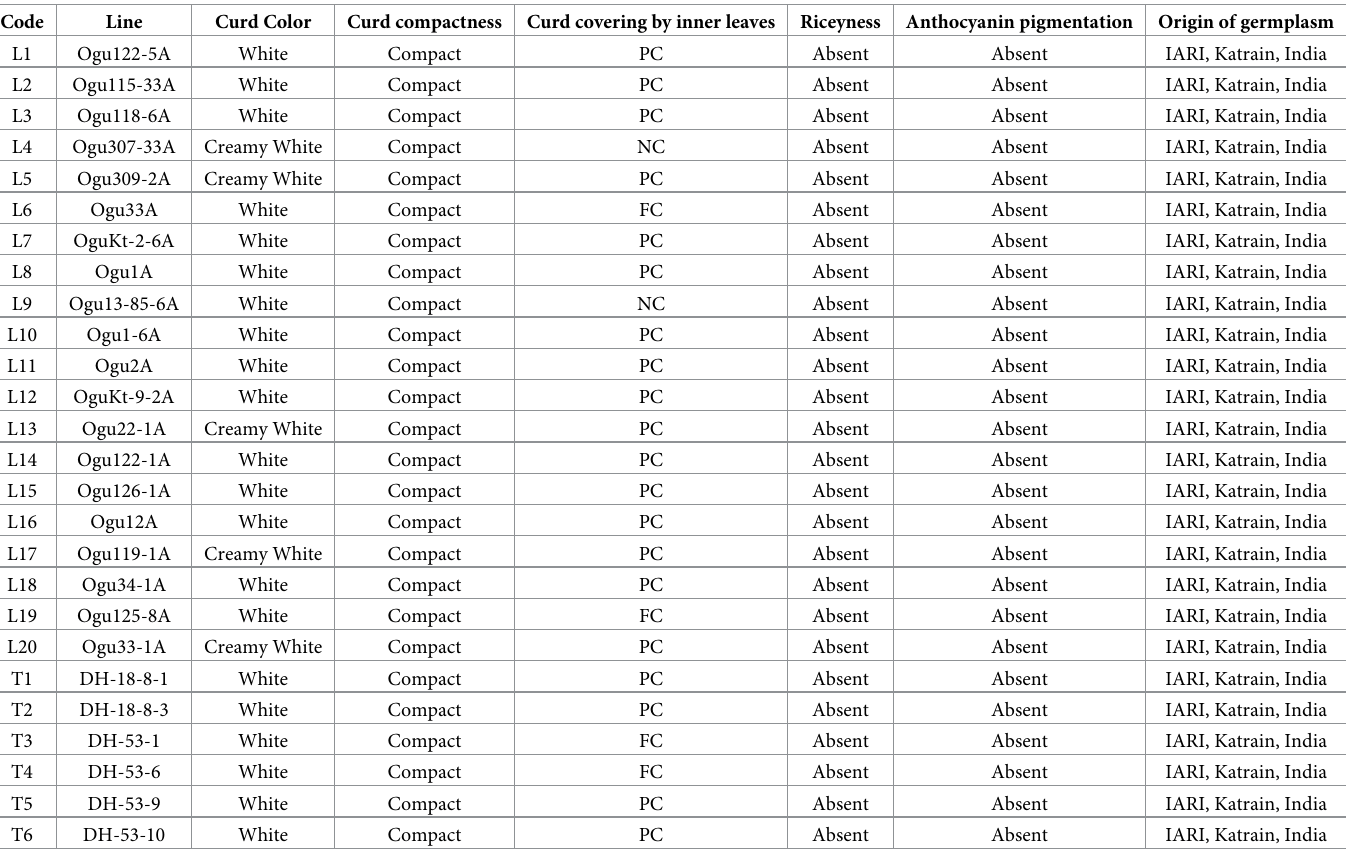
Table 1. Characteristics of parental lines (cytoplasmic male-sterile lines) and testers (doubled haploid lines) used in the study.